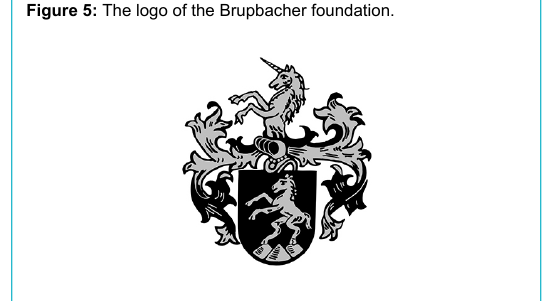
Figure 5: The logo of the Brupbacher